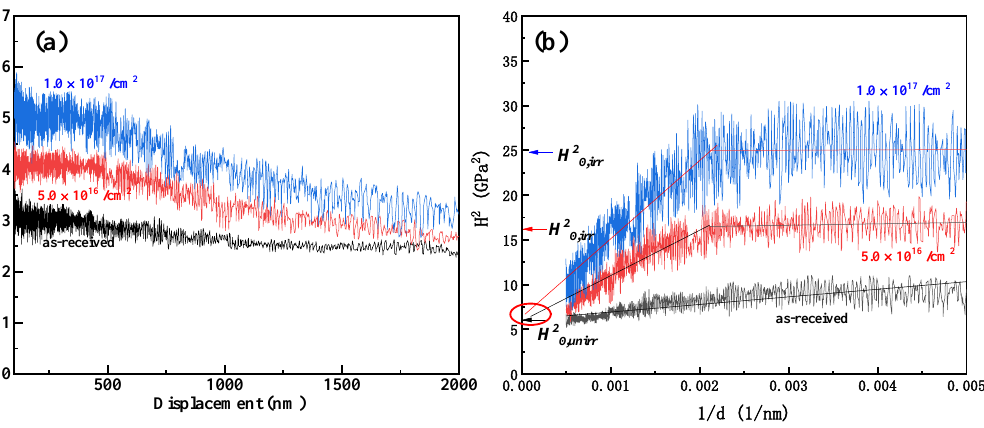
Figure 8. ( a ) Nano-hardness profiles with depth and ( b ) H 2 versus 1/d in as-received and helium irradiated beryllium. Arrows in ( b ) indicate corresponding H 2 of each fitted line.